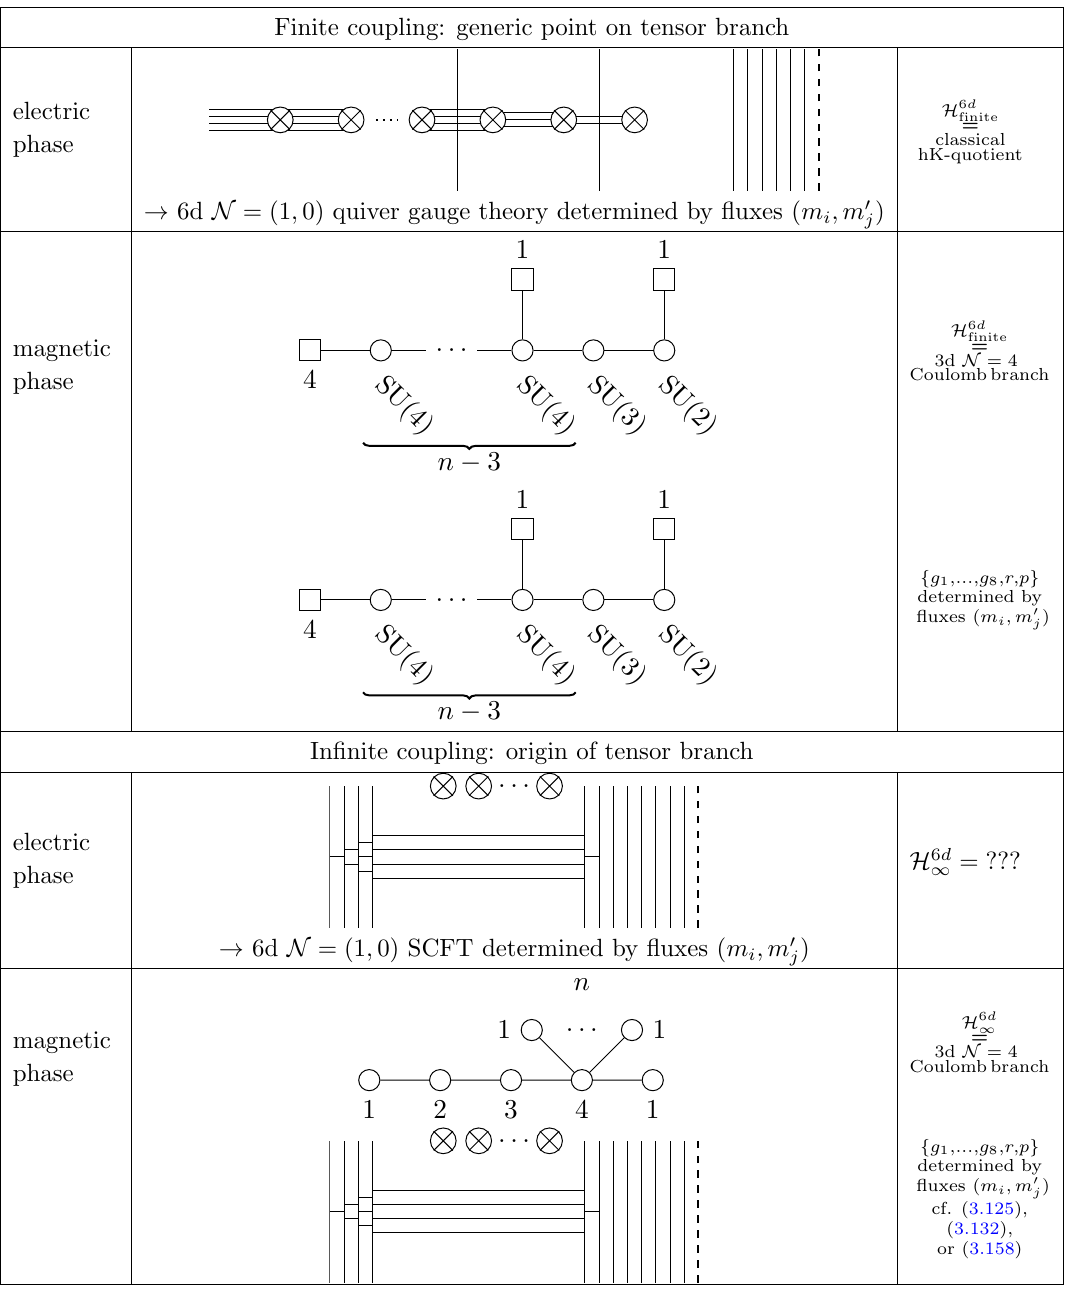
Table 3 . Contrasting the electric and magnetic description of the Higgs branch on a generic point and the origin of the tensor branch. The diagrams are schematics for the general cases discussed in section 3.6. A given embedding Z k , E 8 , labeled by (cid:13)uxed ( m i ; m 0 ) determines the brane j ! con(cid:12)gurations and the resulting magnetic quivers.